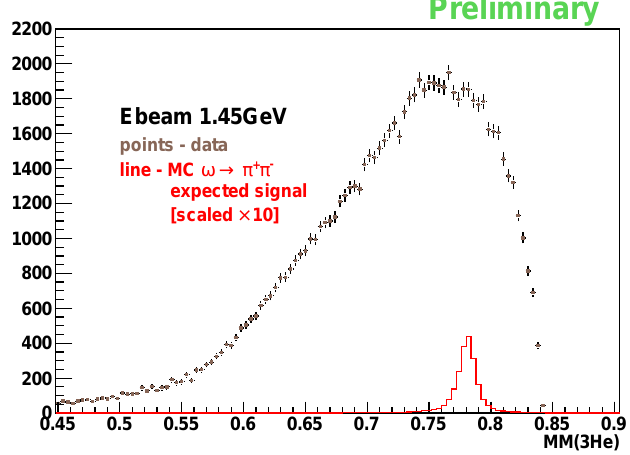
Fig. 3. The preliminary missing mass distribution in the analysis on ω → π + π − . Due to the background, the expected Monte Carlo simulated signal peak has been scaled with factor 10 to make it visible. The distribution is based on data taken with 1.45 GeV kinetic beam